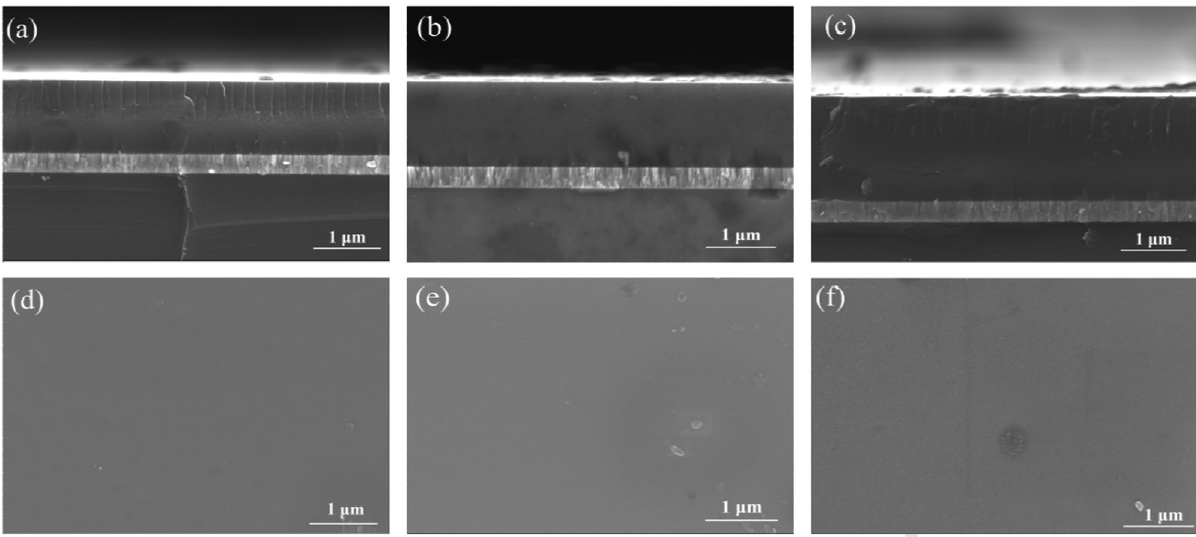
Figure 2: Cross - sectional and planar - view field emission scanning electron microscope images of pure DLC films ( a and d ) , 4.56 at% Si - DLC films ( b and e ) , and 14.56 at% Si - DLC films ( c and f ) [ 45 ]